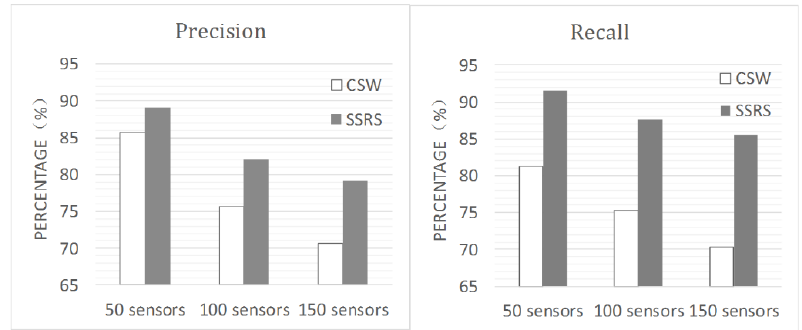
Figure 7. Precision and recall of the operation GetRecords in CSW and SSRS.